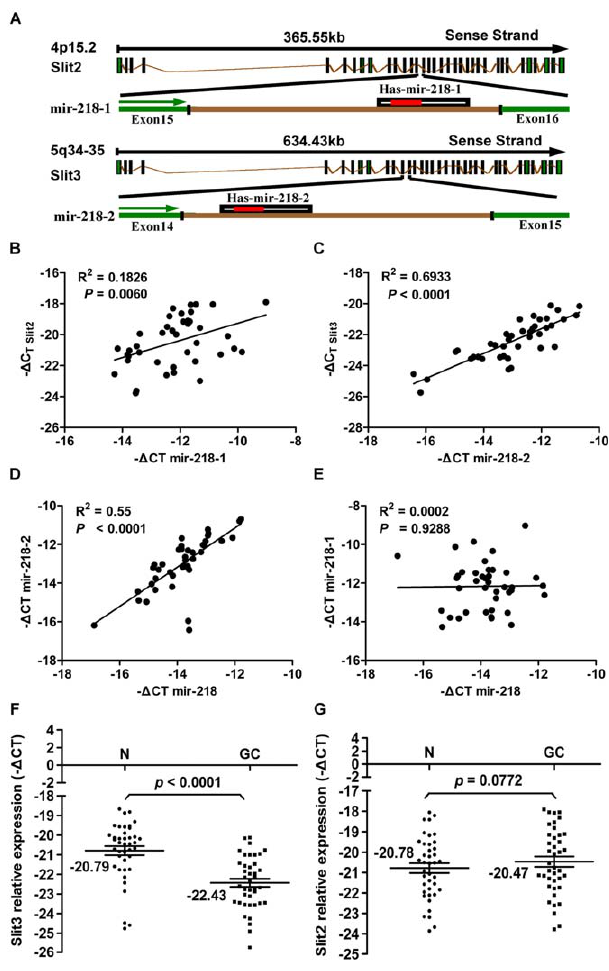
Figure 6. Results of the expression analysis of miR-218, miR- 218-1, miR-218-2, Slit2, and Slit3 in 40 matched GC tumors and corresponding normal tissues via qRT–PCR. (A) Schematic representation of the miR-218 genomic locus hosted in the intron of Slit. Expression patterns of Slit2 with miR-218-1 (B) and Slit3 with miR- 218-2 (C) exhibited a significant positive correlation, as did mature miR- 218 with the miR-218-2 precursor (D), but not with miR-218-1 (E), in GC. A significant differential gene expression pattern was detected between normal and tumor samples with regard to Slit3 ( P , 0.0001, paired Student’s t -test, Figure 6F), but not Slit2 ( P =0.0772, Figure 6G). Using relative quantification methods, the results were expressed as – D Ct. The left and right lines of (F,G) represent the mean values for the normal and tumor groups, respectively.